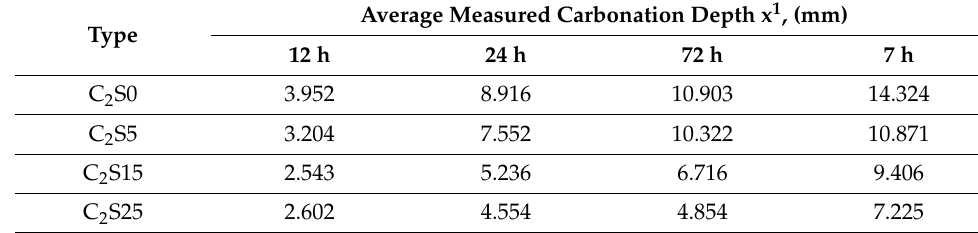
Table 5. Average carbonation depths measured from the